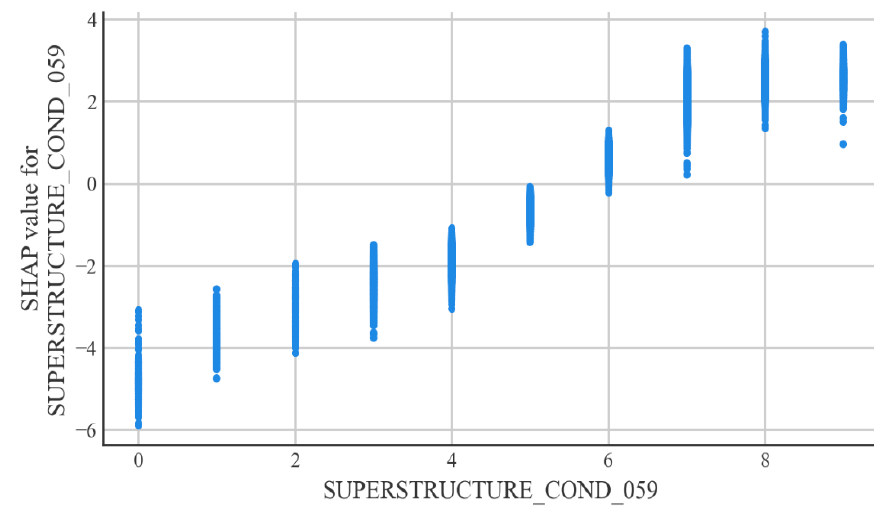
Figure 6. Bridge superstructure condition characteristics dependence diagram.